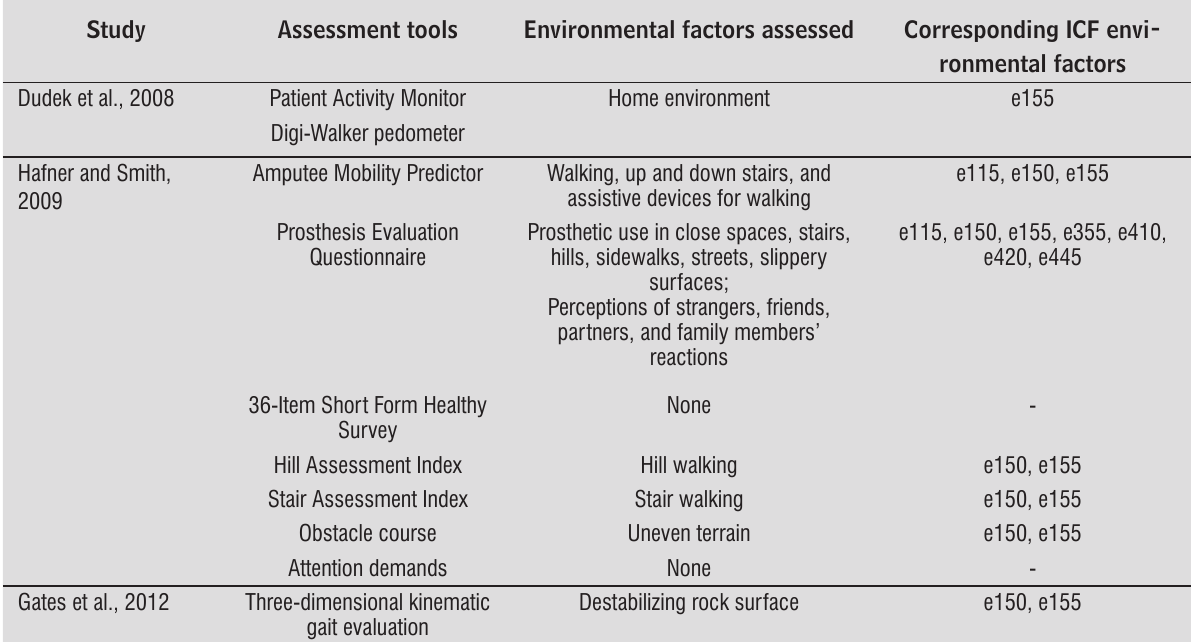
Table 1 - Assessments of environmental factors that can be correlated to the ICF classification